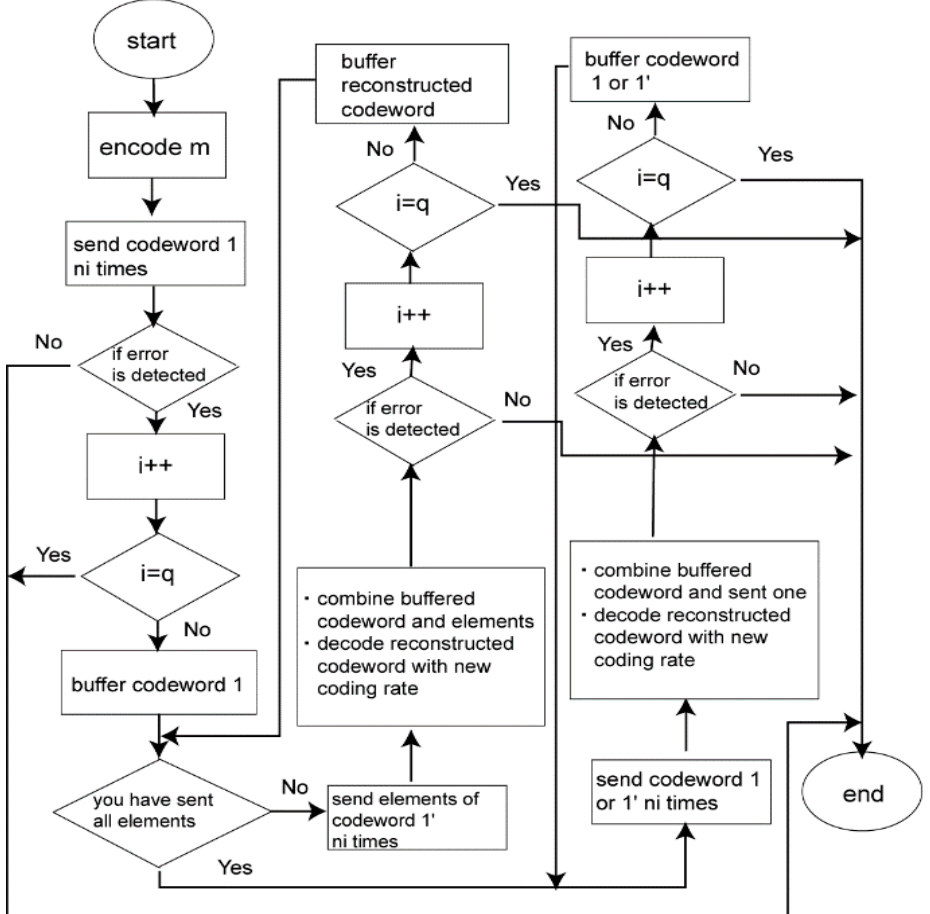
Figure 5. Flowchart of the proposed automatic repeat request (ARQ) protocol [20–22].